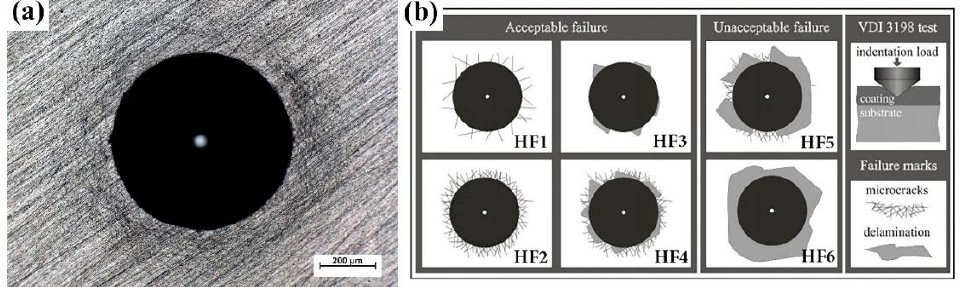
Figure 8. ( a ) OM indentation morphology of produced layer on bainitic steel; ( b ) the VDI-3198